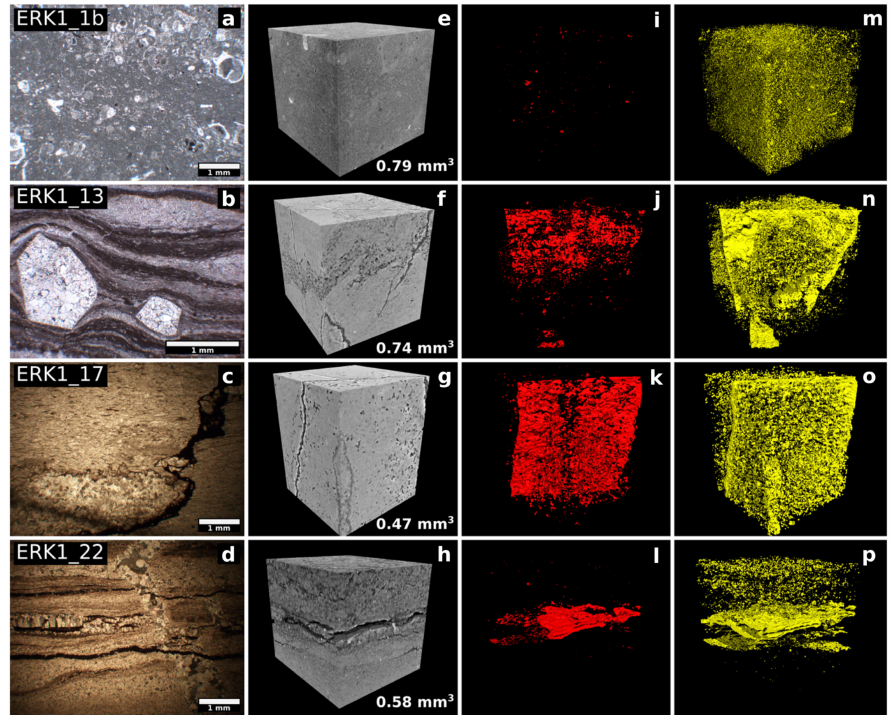
Figure 7. Microstructural features of some representative specimens. From left to right column: ( a – d ) main microstructural features (optical microscope); ( e – h ) volume renderings of extracted Volumes of Interest (VOIs) in grayscale from SR- µ CT; ( i – l ) segmented pores and fractures from the same VOIs; ( m – p ) mineralization array (yellow) along the fractures. ERK1_1b: bioclastic wackestone; ERK1_13: detail of polycrystalline calcite within algal mats; ERK1_17: load and tectonic stylolites; ERK1_22: swallow tail gypsum interbedded within the laminae and cut by fracture filled with secondary